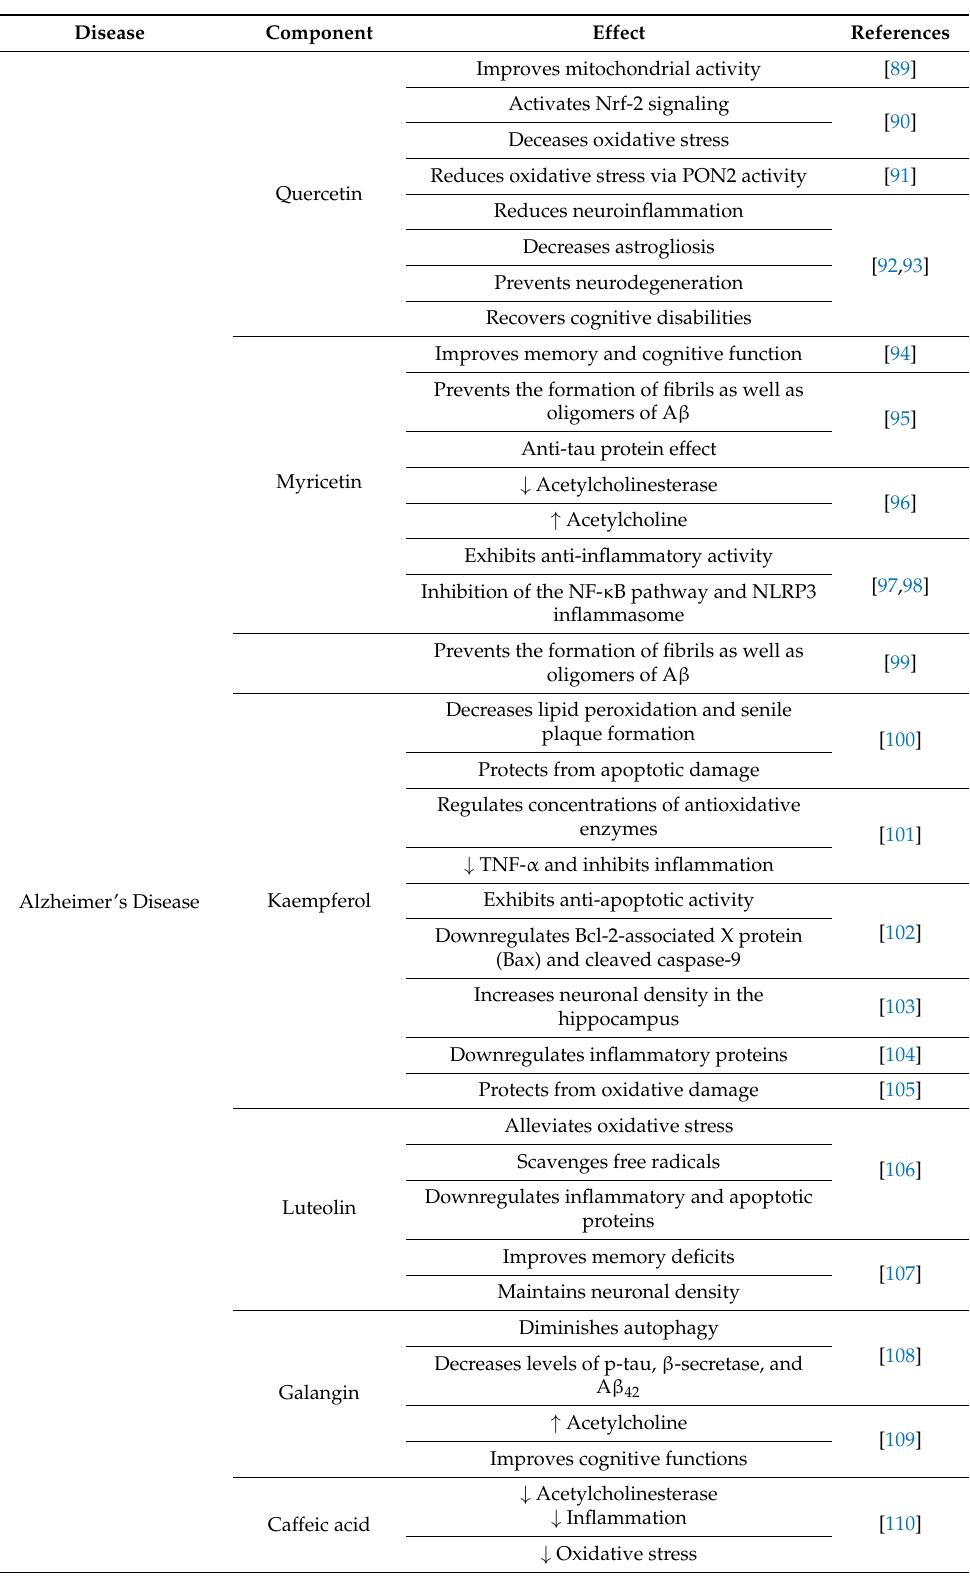
Table 2. Effects of Different Components of Honey in Various Neurological